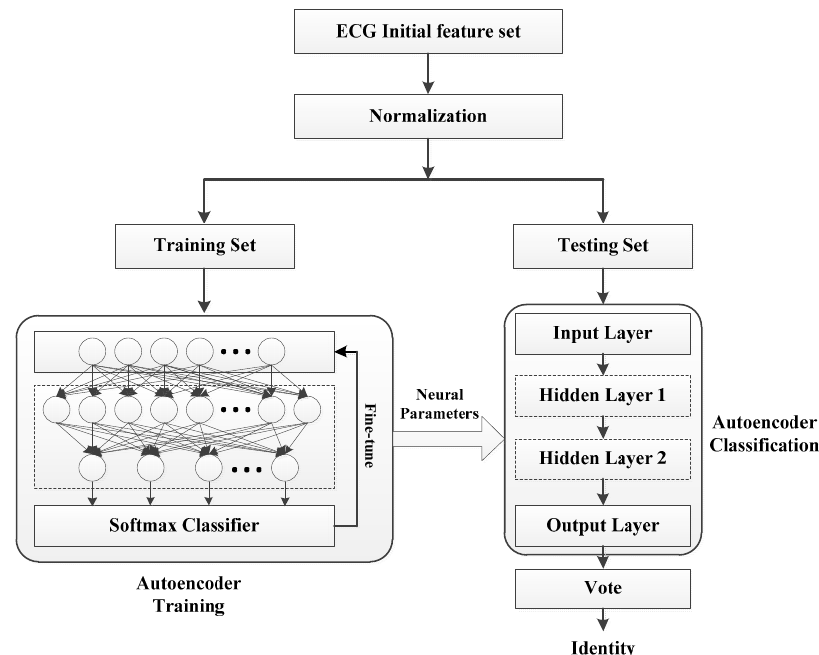
Figure 6. The overall framework of the proposed method for ECG biometric identification.